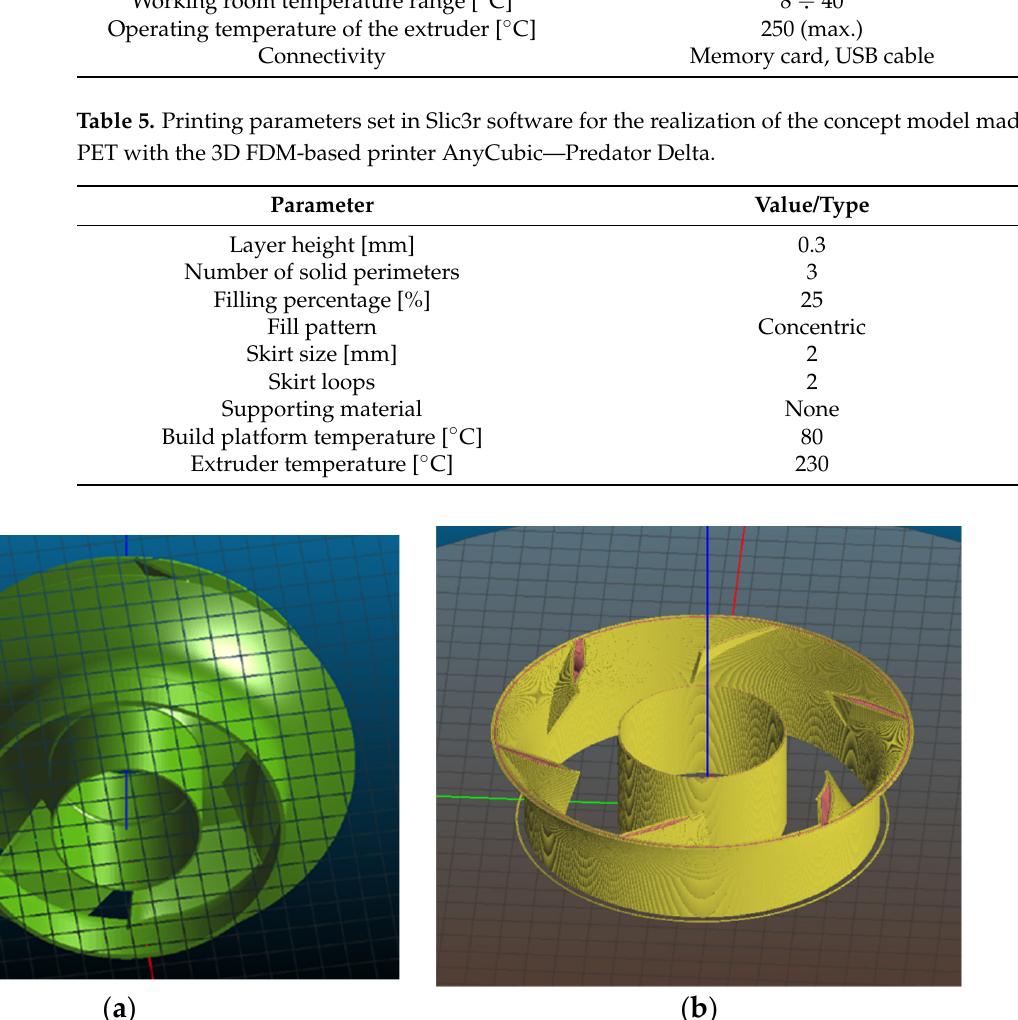
Figure 7. Support tube added to the upper flared part of the impeller in order to avoid using the support material suggested by the slicing software: ( a ) bottom view and ( b ) internal view.